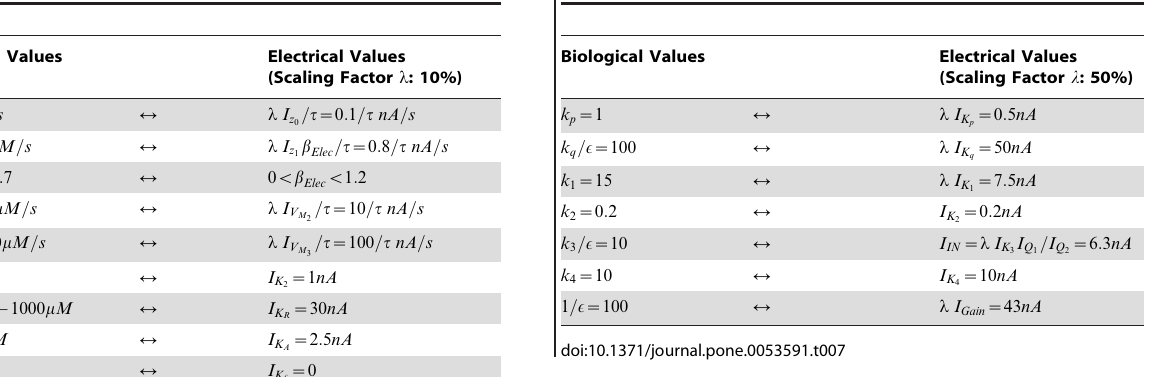
Table 7. Biological And Electrical Values For The Gene- Protein Regulatory Model (2D - Case) for E ~ 0 : 01 .